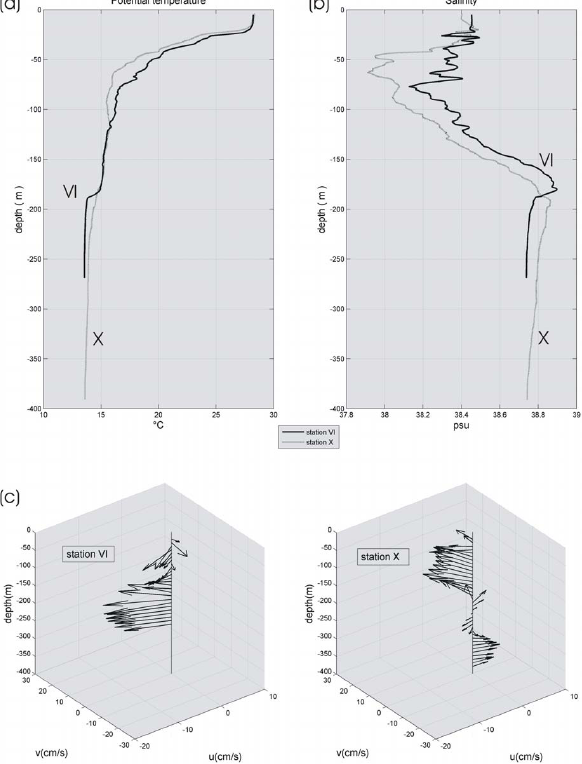
Figure 3. Vertical structure of the vein in correspondence of stations VI and X of Figure 1b. Fig. 3. Vertical structure of the vein in correspondence of stations (a) Potential Temperature, (b) Salinity, (c) Current Velocities. VI and X of Fig. 1b. (a) Potential Temperature, (b) Salinity, (c) Current Velocities.